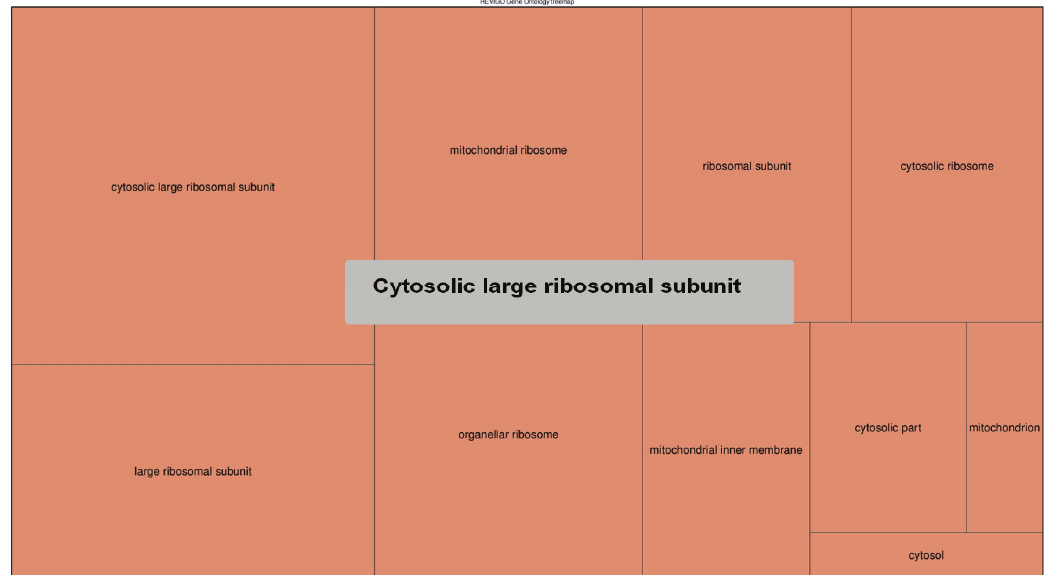
Figure 8. The GO terms (cellular components) that were enriched for genes void of 5-hmC. The areas of rectangles are proportional to the relative increase in frequency of GO terms comparing genes that completely lacked 5-hmC-related peaks to genes that had them. The corresponding quantitative data and a full list of GO terms can be found in Supplementary File S4.